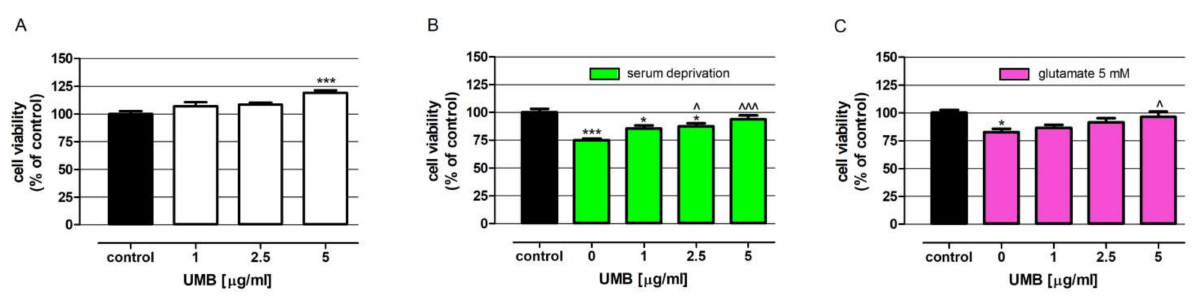
Figure 3. Influence of UMB on the viability of neurons under standard or degenerative conditions: trophic stress (serum deprivation) and glutamate excitotoxicity (5 mM glutamate). Neurons derived from human neuroblastoma cell line SH-SY5Y were exposed for 48 h to UMB at concentrations 1, 2.5 and 5 µ g/mL prepared in culture medium alone (control) ( A ), or serum-deprived cell culture medium ( B ) or with 5 mM glutamate ( C ). Cell viability was measured photometrically using an MTT assay. Results are presented as the mean of at least 4 measurements. Statistically significant differences compared to the control at * p < 0.05, *** p < 0.001; statistically significant differences compared to the degenerative conditions at ˆ p < 0.05, ˆˆˆ p < 0.001. One-way ANOVA test and Tukey’s post-hoc